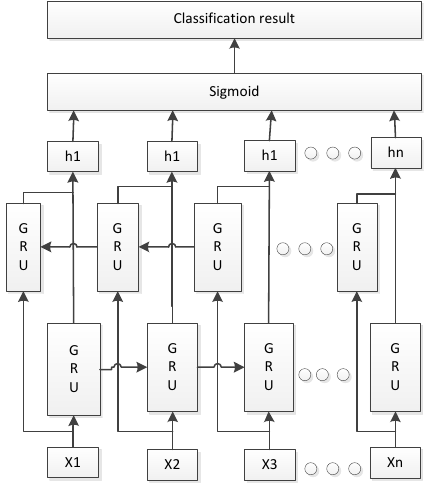
Figure 1. BIGRU Network Structure.